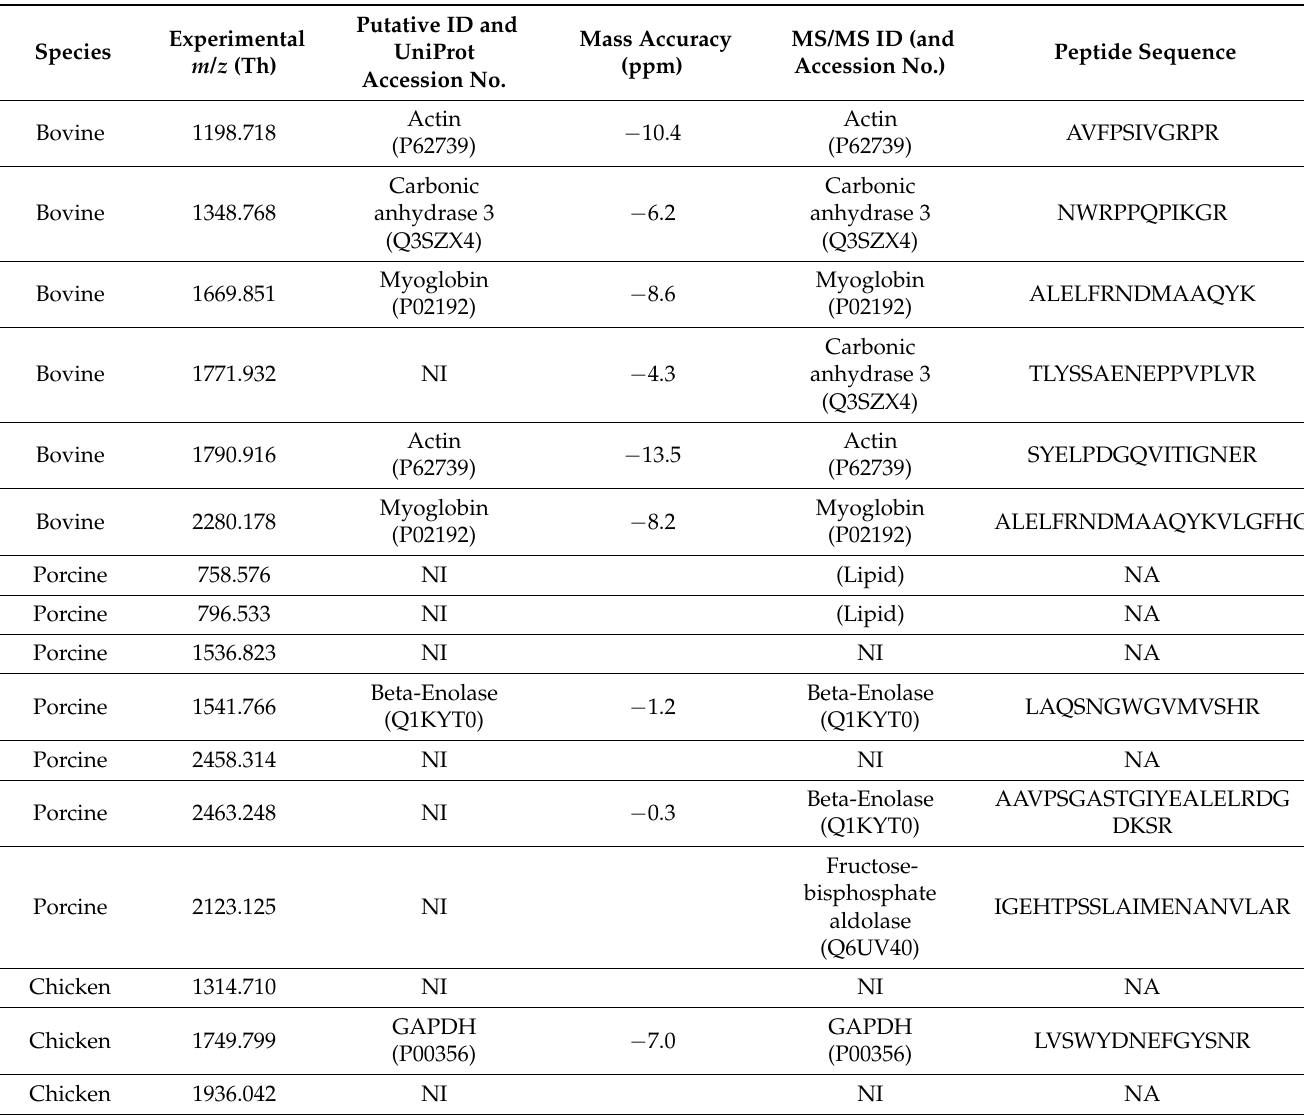
Table 4. Animal species discriminatory supervised PCA ion signals (from Figure 4) selected putative identification and MS/MS confirmation for blood in packaged meat. (NI: Not Identified; NA: not